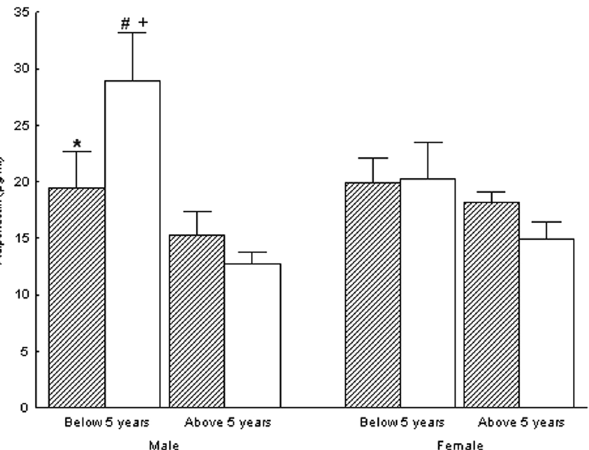
Figure 3. Adiponectin in the IUGR (hatched bars) and AGA (white bars) groups. Significant differences were assessed by One-Way factors ANOVA (p < 0.05). + denotes statistically significant difference from the respective female group. * denotes statistically significant difference from the respective AGA group. # denotes statistically significant difference from the respective group of more than 5 years old age.